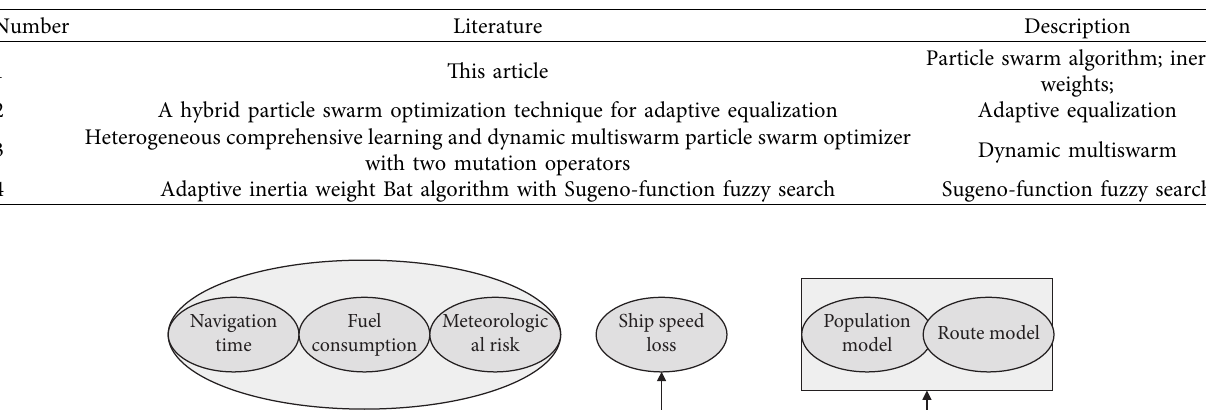
Table 1: Literature review.